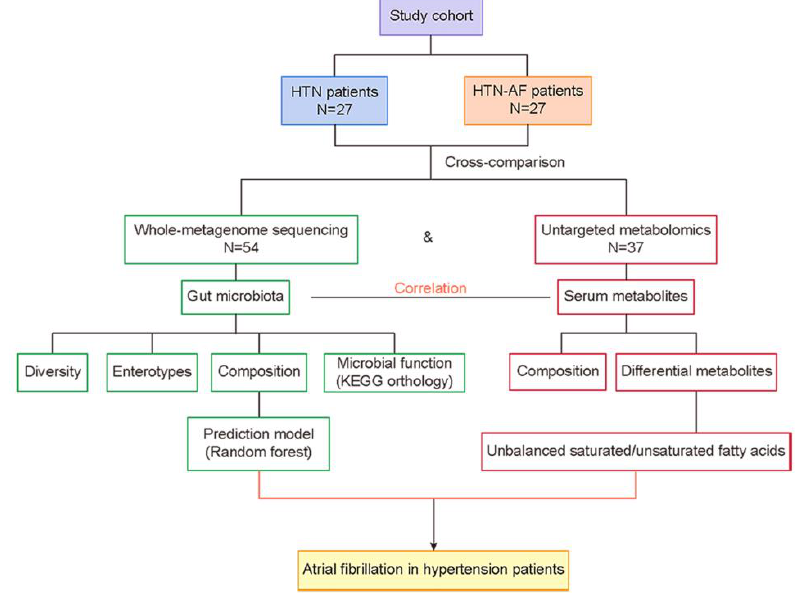
Figure 1. Overview of the workflow. AF, atrial fibrillation; HTN, hypertension.